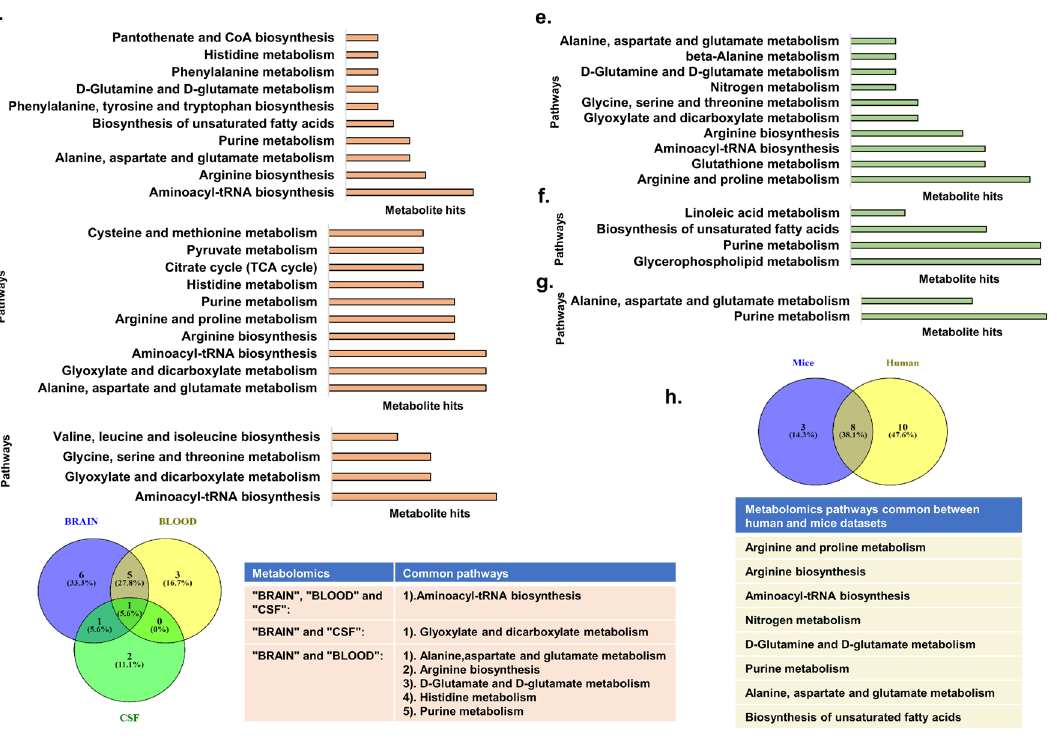
Figure 4. Pathway analysis of differential metabolites between healthy controls and Alzheimer’s patients using MetaboAnalyst tool ( a ). Brain ( b ). Blood serum ( c ). Cerebrospinal fluid (CSF) ( d ). Common metabolomic pathways in humans. Metabolomics analysis of mice datasets. ( e ). Brain ( f ). Blood ( g ). Cerebrospinal fluid ( h ). Common metabolomic pathways between humans and mice. Figure generated using Venny